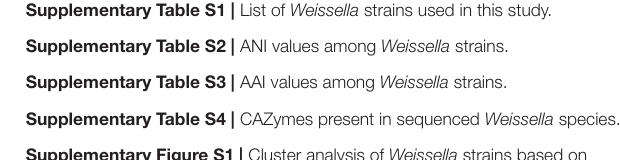
Supplementary Table S3 | AAI values among Weissella strains. Supplementary Table S4 | CAZymes present in sequenced Weissella